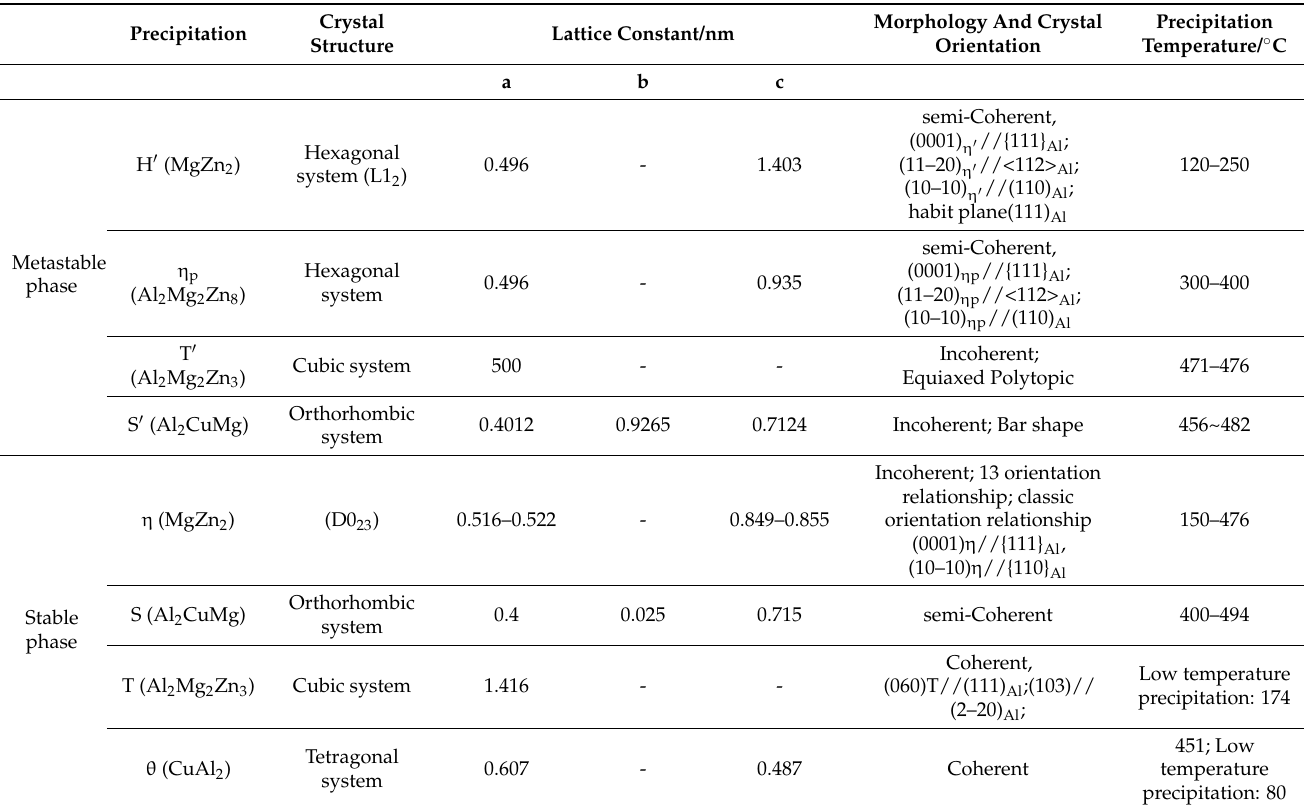
Table 4. Morphology and structure characteristics of main precipitates in 7xxx series aluminum alloy [50–54].